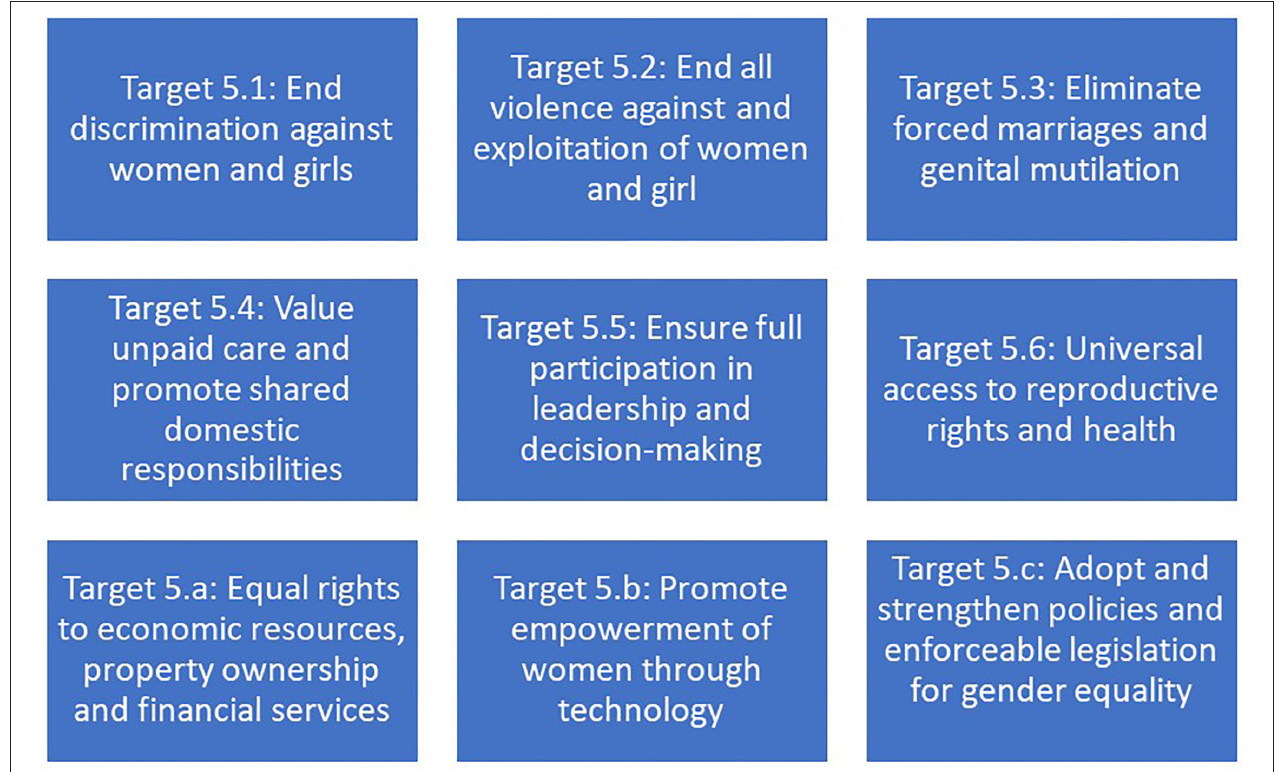
FIGURE 1 | Sustainable development goal 5 and its targets. Source: Authors’ compilation based on the